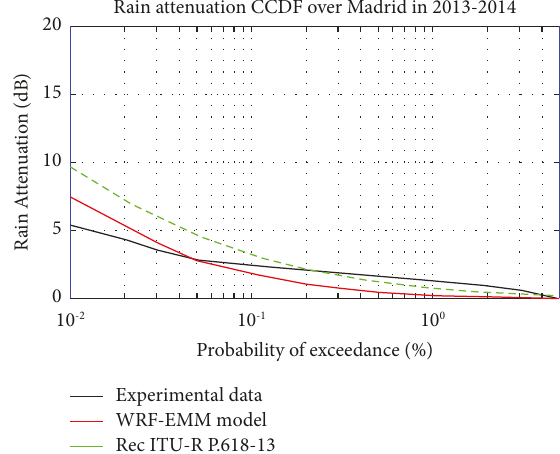
Figure 7: Comparisons between CCDFs computed from data measured in Madrid in 2013–14 (97.9% availability), WRF-EMM simulations and Rec. ITU-R P.618–13 using R 0.01 predicted with Rec. ITU-R